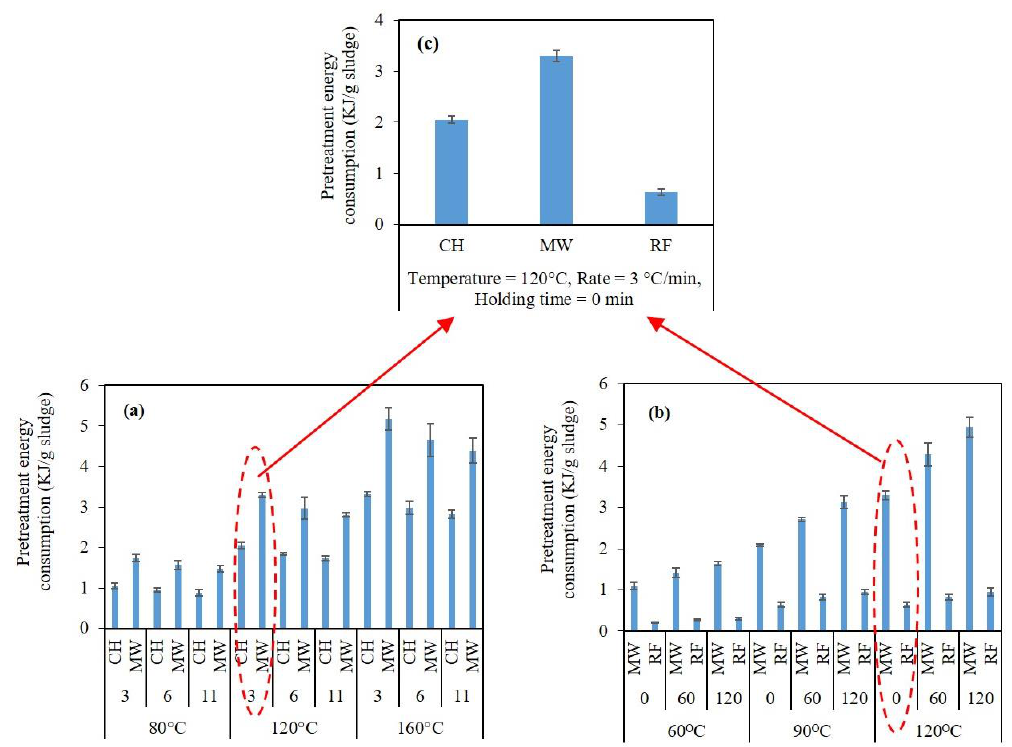
Figure 4. Electrical energy consumption (input energy) during different pretreatment condition; ( a ) CH vs. MW; ( b ) MW vs. RF; ( c ) CH vs. MW vs. RF. ( a ) CH vs. MW; ( b ) MW vs. RF; ( c ) CH vs. MW vs.